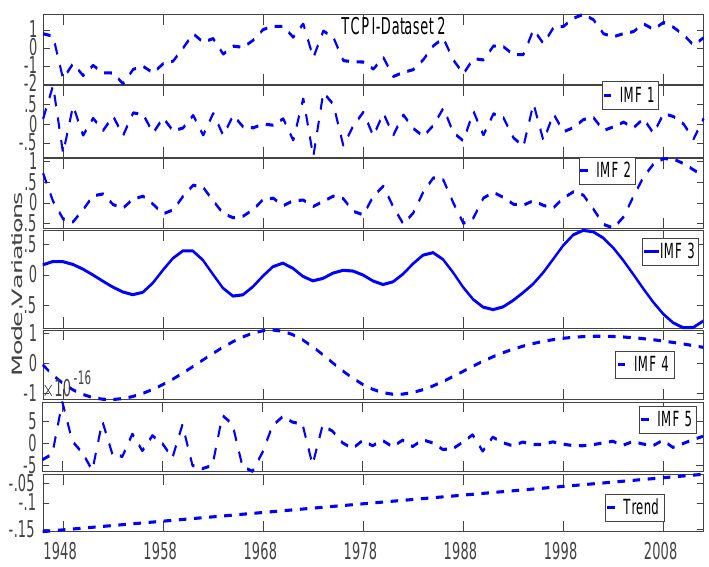
Figure 3. The EMD analysis of the TCPI signal in the North Indian Ocean. TCPI used here is derived using Dataset-2. The derived signal is shown in the first panel and its increasing trend in the seventh panel.